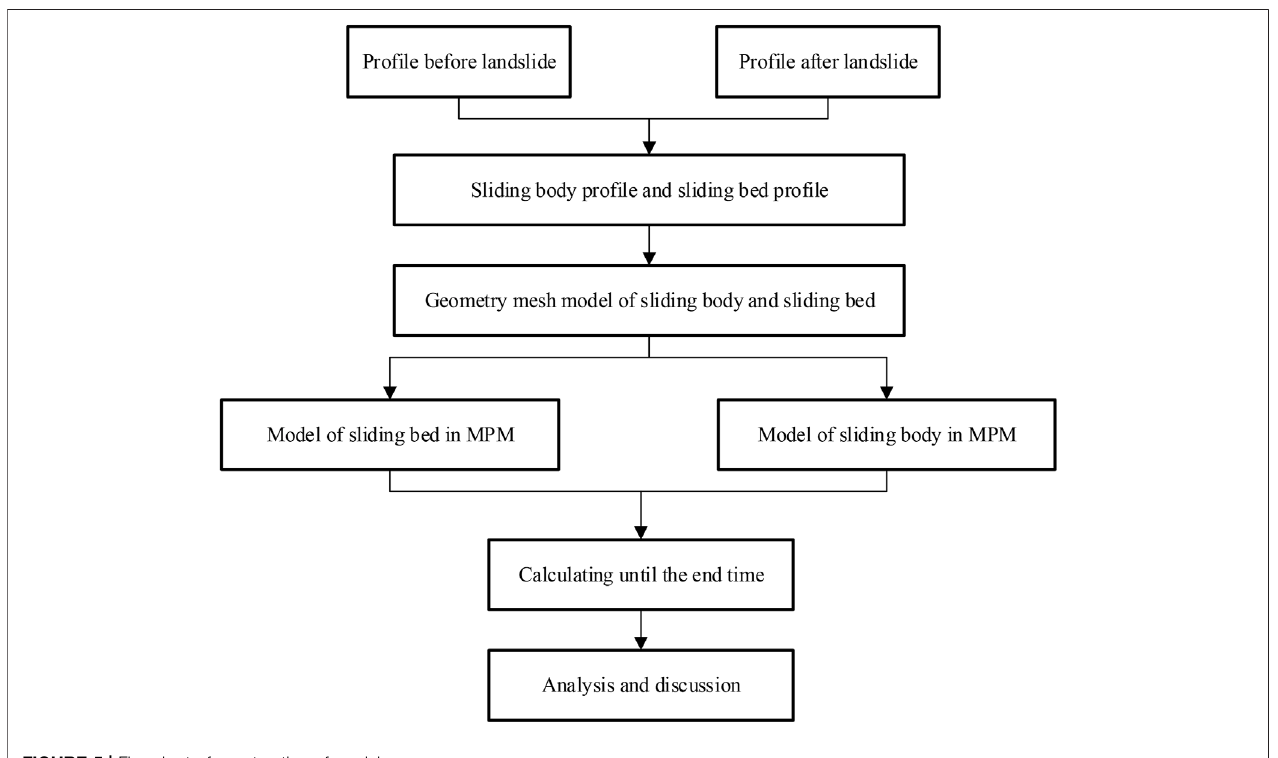
FIGURE 5 | Flowchart of construction of model.